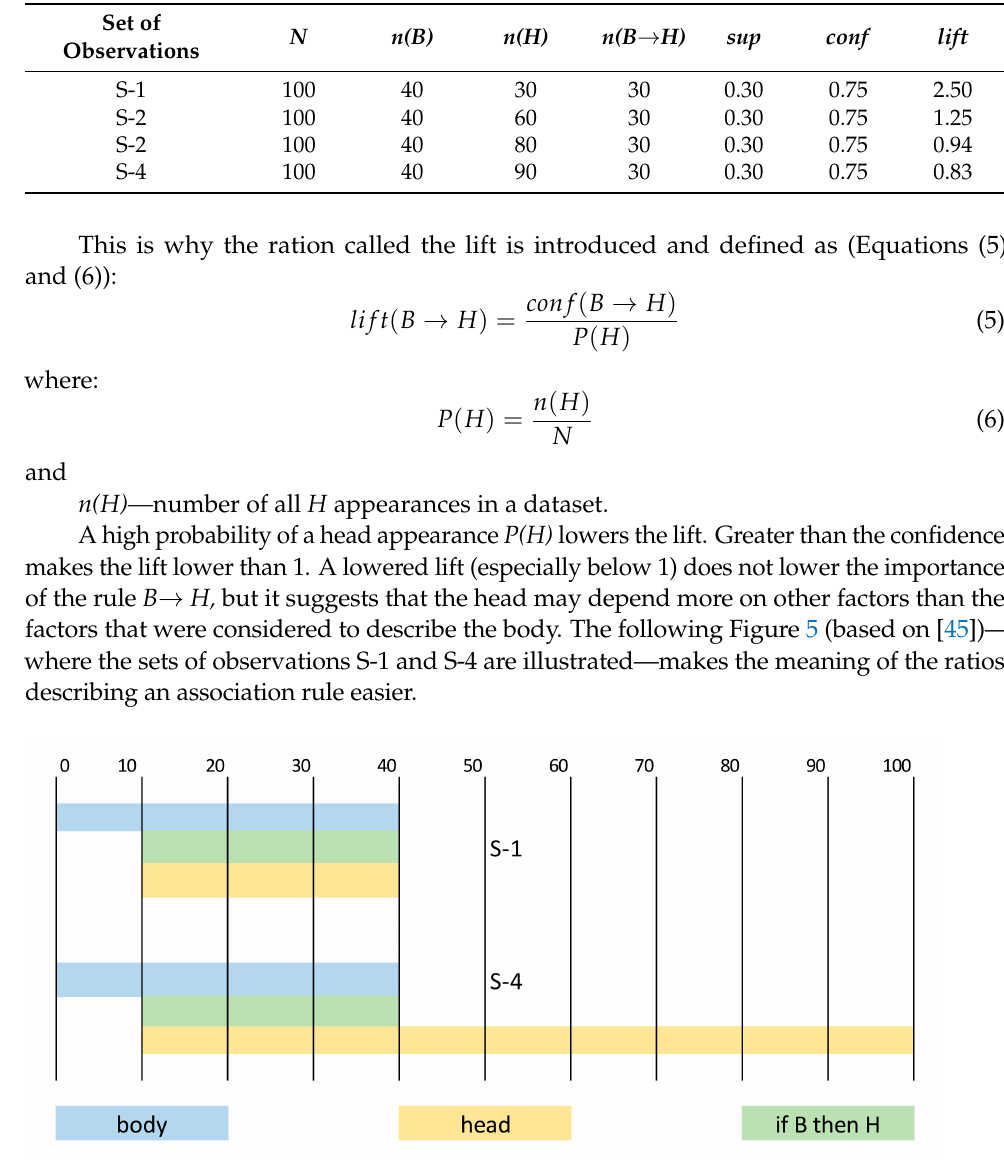
Figure 5. Graphical presentation of the rules with identical sup and conf , but different lift